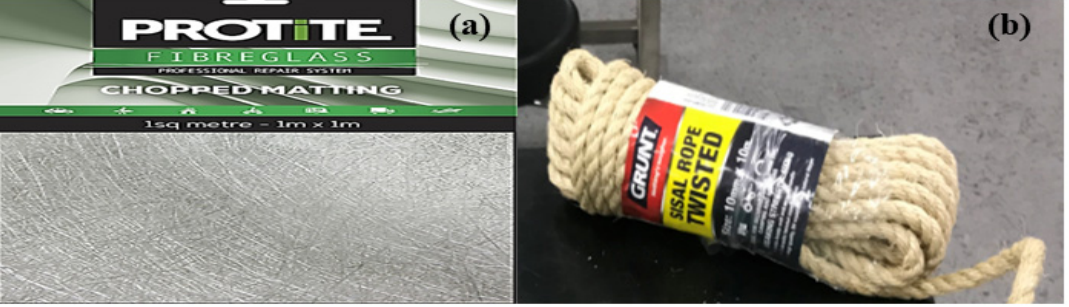
Figure 1. ( a ) Glass fibres rope as a reinforcement for epoxy and ( b ) sisal fibres rope as a reinforcement for epoxy.